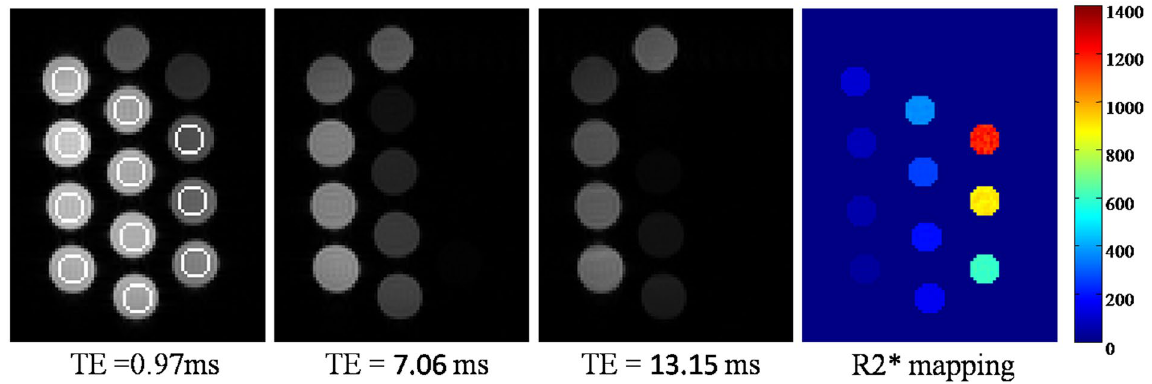
Figure 5. Example of the phantom images (AVG = 256) at TEs of 0.97 ms, 7.06 ms, 13.15 ms and the R2 * mapping obtained from the less noisy images (AVG = 256). Circles in the first image indicate the selected